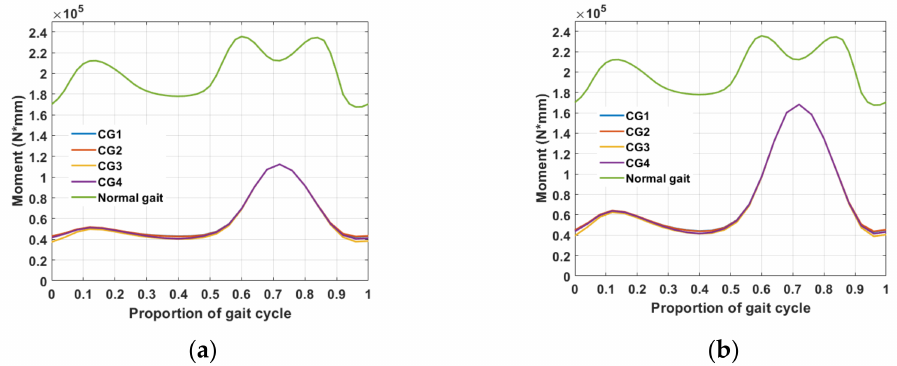
Figure 10. Graphs of passive elements with motorized angular knee correction using ( a ) 20 k Nmm/deg torsion springs and ( b ) 30 k Nmm/deg torsion